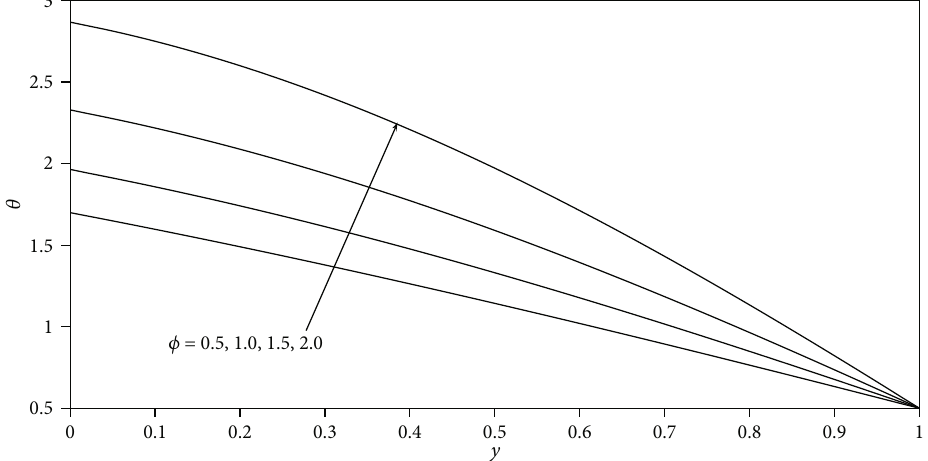
Figure 9: Temperature pro fi les for di ff erent values of ϕ at R = 0 : 5 .